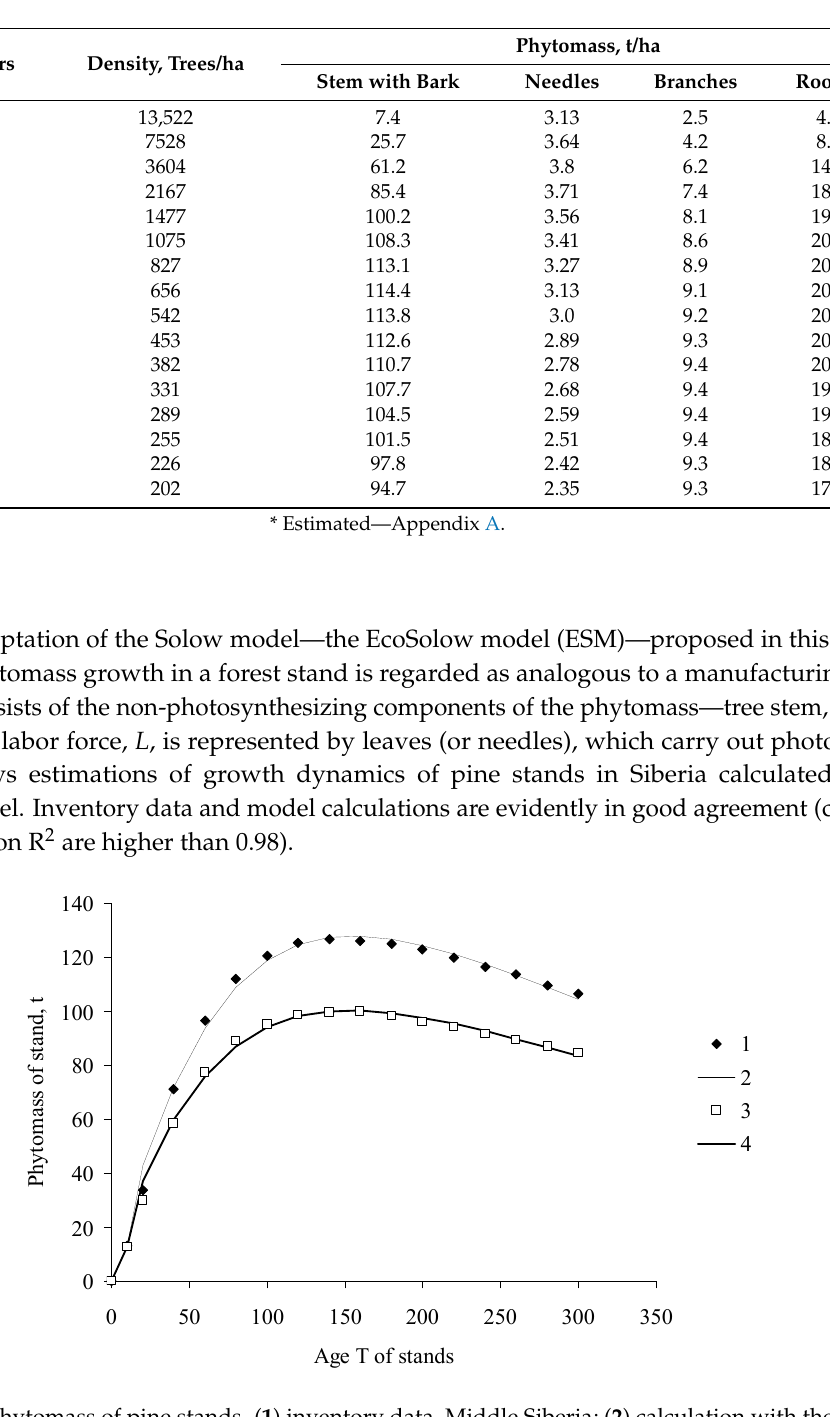
Table 1. Middle Siberia, south taiga.